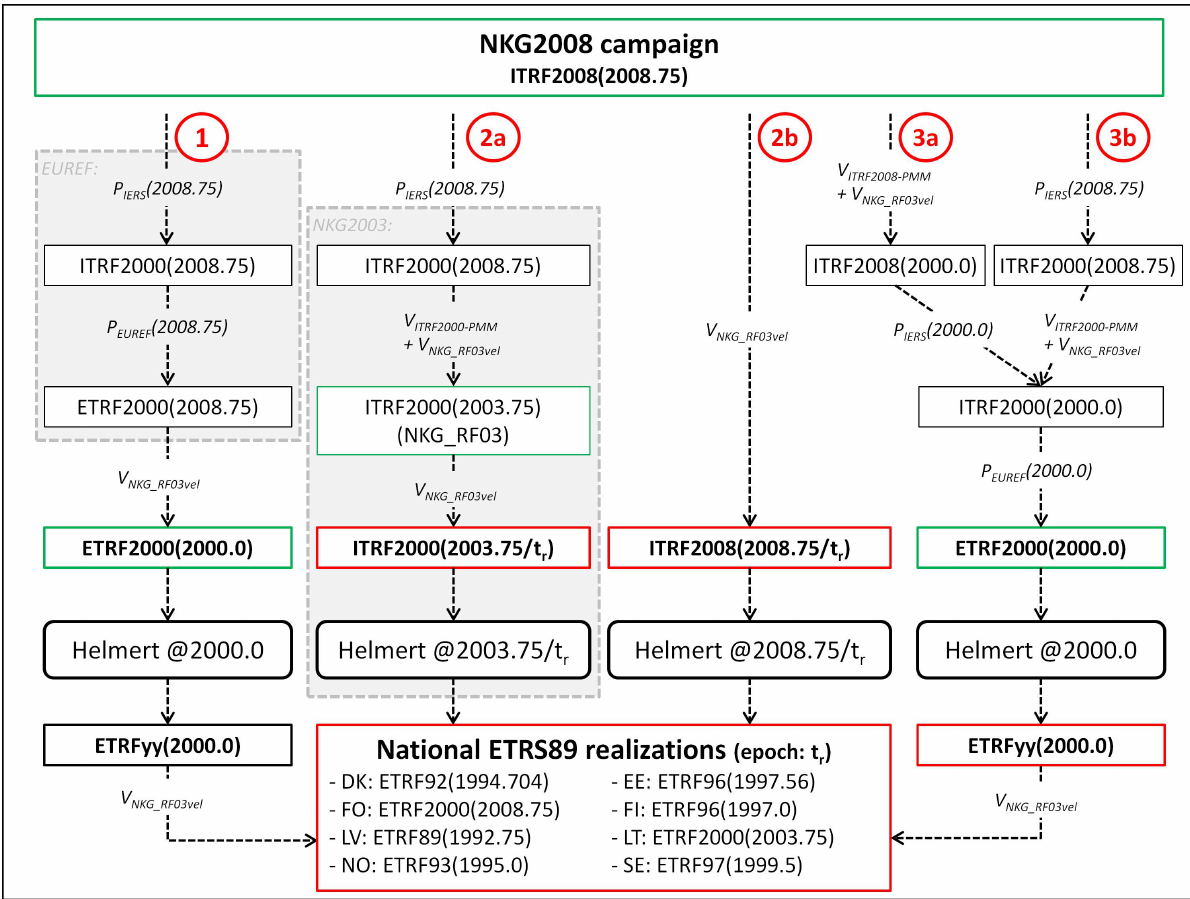
Figure 1: Some potential transformation alternatives. Options for the common frame are shown with green boxes while red boxes indicate input coordinates (that are not in a common frame) for defining the transformation parameters. Parts inside grey-shaded boxes indicate steps that are included either in the EUREF or in the NKG2003 transformations. P IERS ( t ) or P EUREF ( t ) refer to the transformation (parame- ters) recommended by either the IERS or the EUREF at the epoch t . V ITRF 200 x − PMM is a correction for the rigid plate motion according to cor- responding ITRF200x plate motion model. V NKG RF 03 vel is a correction for intraplate deformations from the model NKG RF 03 vel .